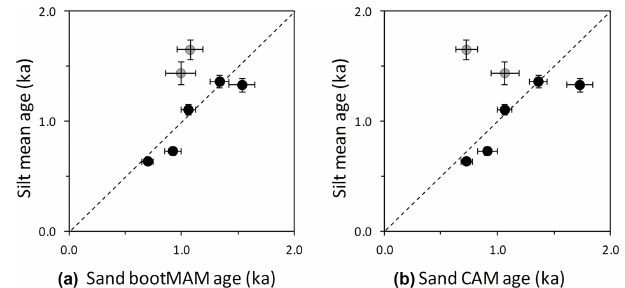
Figure 7. Comparison of mean ages of silt fractions with ages ob- tained using the (a) bootMAM and (b) CAM on paired sand frac- tions, isolated from the same samples ( n = 7) of overbank deposits. Samples were collected by Shen et al. (2015) and reanalyzed here using early background subtraction plus other criteria. Gray cir- cles indicate PV I-4 and PV I-5, two samples possibly affected by feldspar contamination of the silt fraction or containing poorly bleached